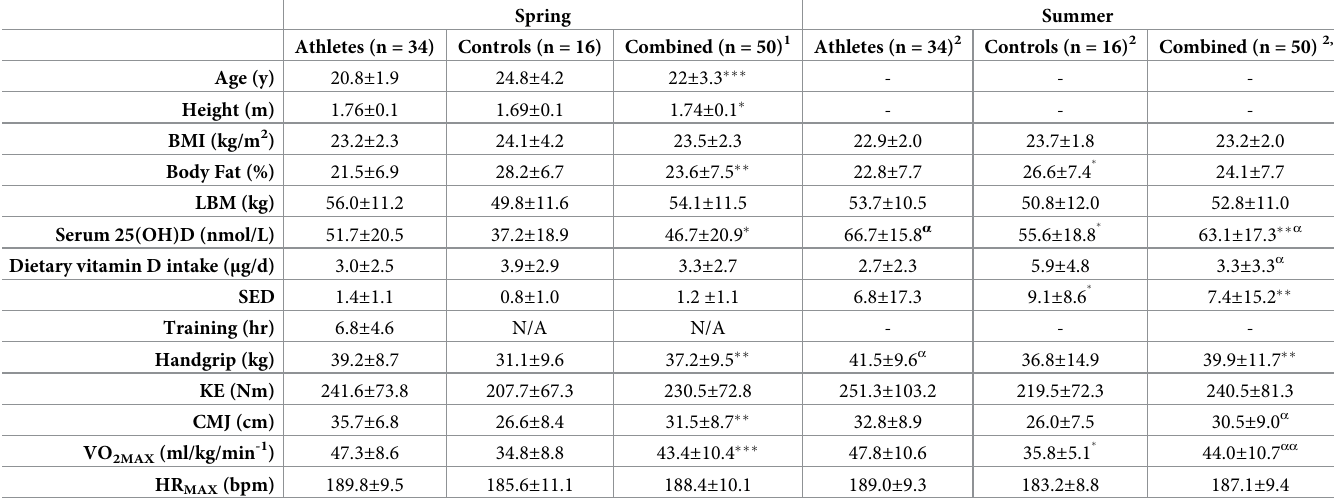
Table 1. Participant demographics and physical performance parameters.